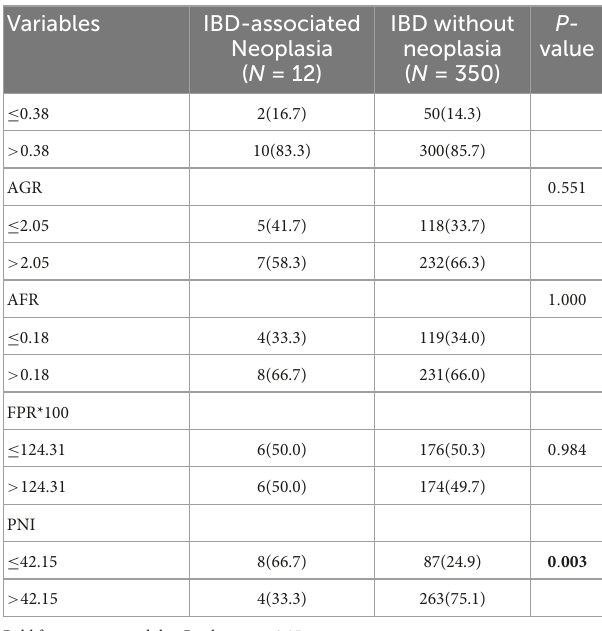
TABLE 4 Analyses of clinical and peripheral blood parameters of Patients with IBD-associated Neoplasia vs. patients without